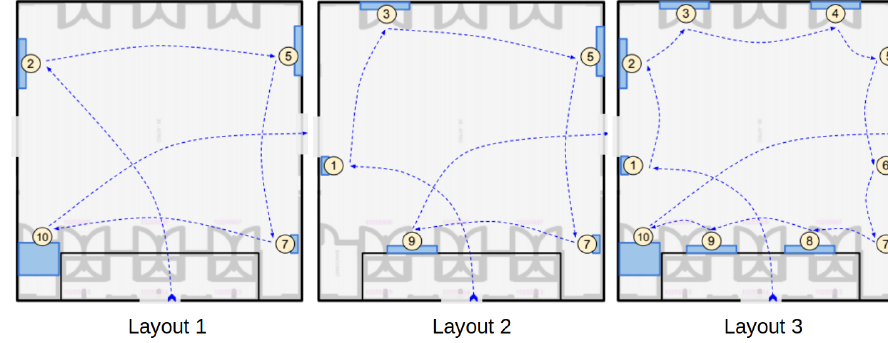
Figure 15. The three visiting layouts for Pilot 1.